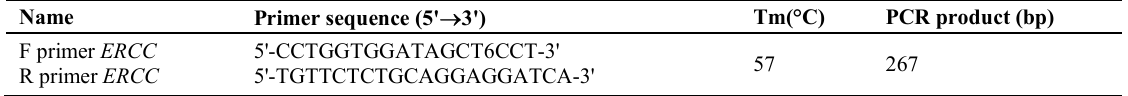
Table 1. Characteristics of the primer used and restriction enzyme Name Primer sequence (5'  3') Tm(°C) PCR product (bp)